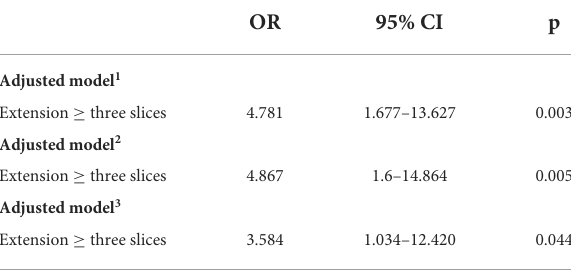
TABLE 2 Associations between infarct extension ≥ three slices and progressive